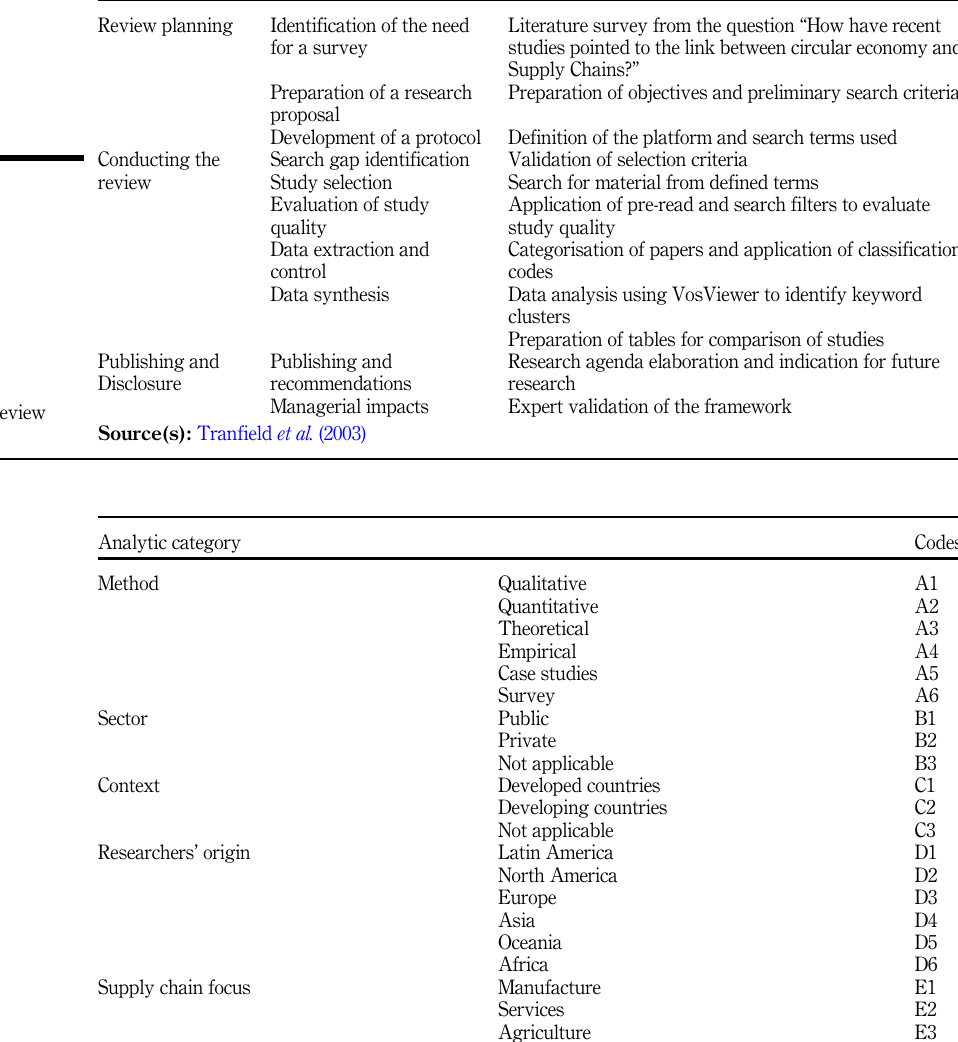
Table 4. Applied